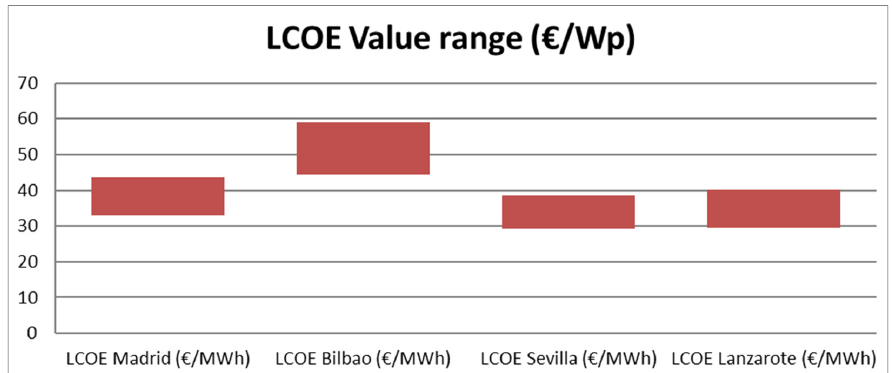
Figure 13. LCOE value range for each of the locations studied.